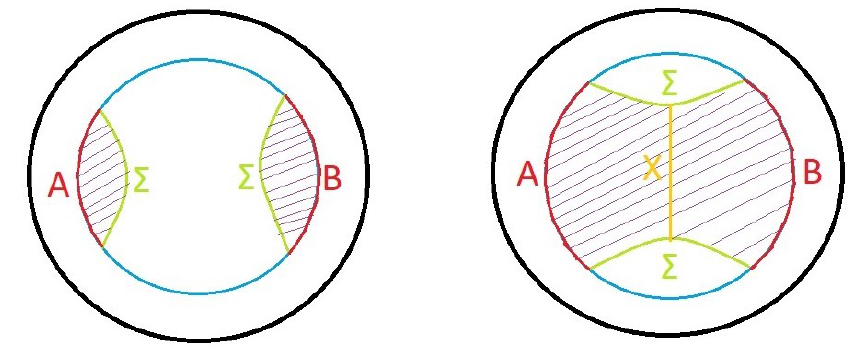
Figure 4 . The cuto(cid:11) slice is in blue and part of it | subsystems A and B in red. The shaded region is the EW. Left : if A and B are small and not close then the RT surface for A [ B is union of RT surfaces for A and B so the entanglement wedge is disconnected. Hence there is no neck inside the entanglement wedge meaning that EoP is zero. Right : if A and B are large and close enough then the RT surface of A [ B is di(cid:11)erent from the union of RT surfaces of A and B and the entanglement wedge is connected. The neck is part of a great circle X stretching through the